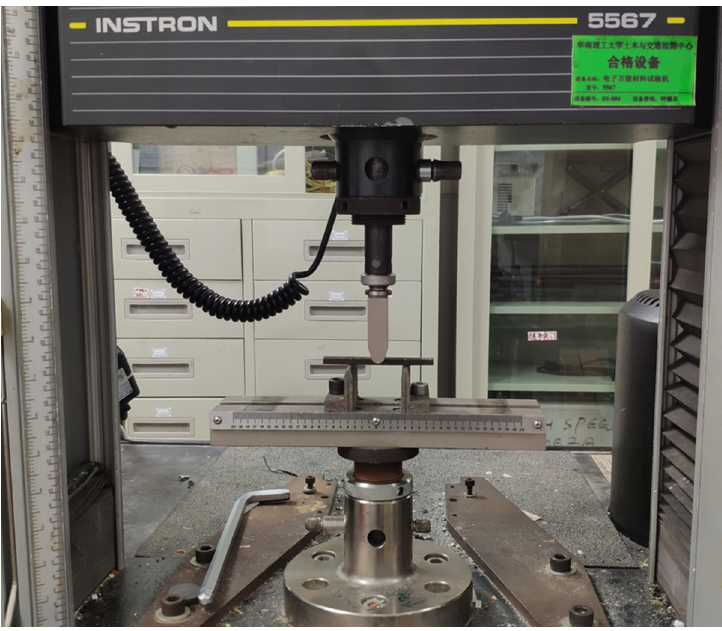
Figure 6. Three-point bending test of epoxy mortar specimens.